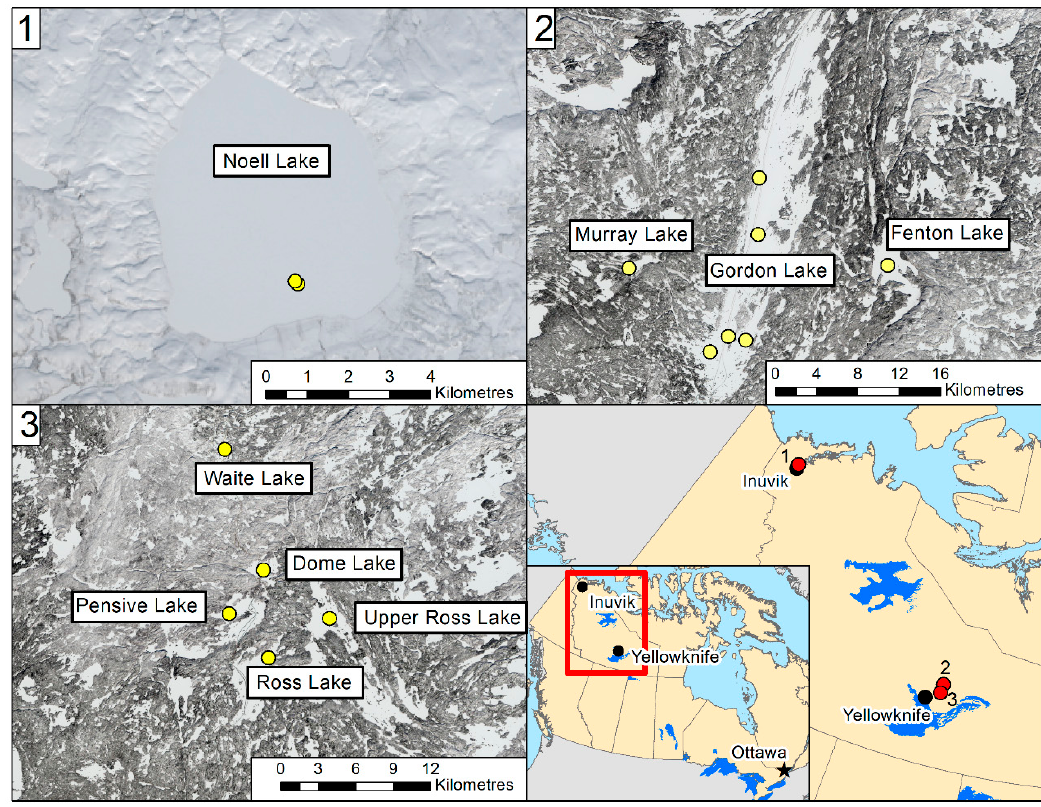
Figure 3. Location of modular GNSS stations deployed at lake ice sites, Northwest Territories, Canada.